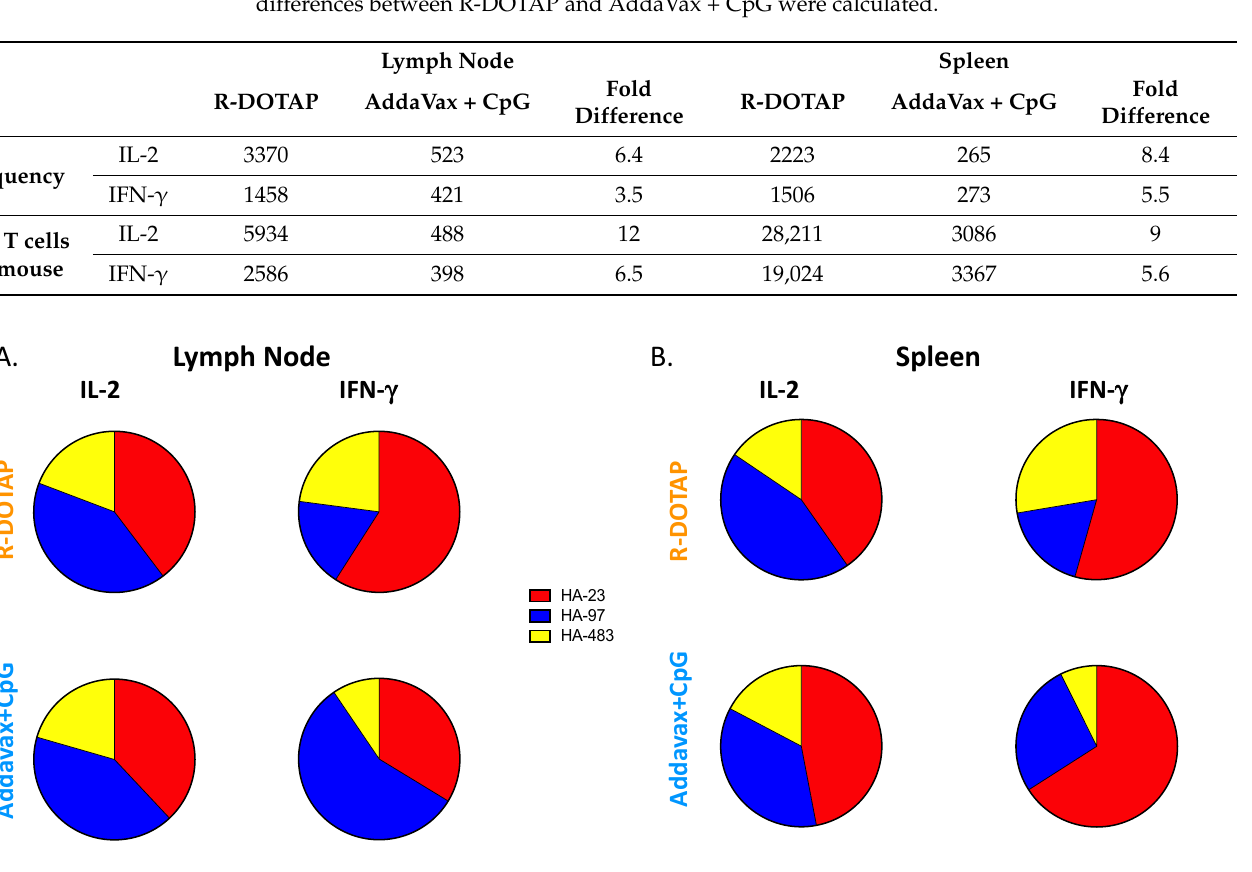
Figure 4. Mice were immunized subcutaneously with B/Malaysia HA protein in adjuvant and tissues were harvested at day 10/11 post-vaccination. Shown are pie diagrams of the average response from three independent experiments illustrating the fraction of the response dedicated to each of the peptide epitopes, with R-DOTAP on the top and AddaVax + CpG on the bottom. To the left ( A ) is the response in the draining popliteal lymph node and to the right ( B ) is the response in the spleen detected by IL-2 and IFN-y ELISpot. There was no statistical difference in the relative immunodominance between R-DOTAP and AddaVax + CpG.